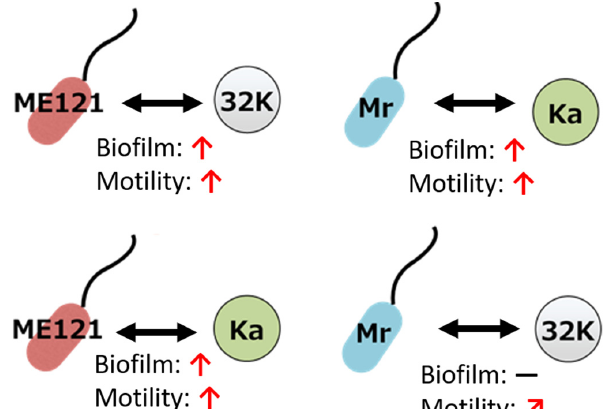
Figure 7. Schematic diagram of the effects on biofilm formation and motility of each strain. “ ↑ ” shows increased biofilm formation and accelerated motility. “ － ” shows no effect on biofilm formation. “ ↗ ” shows moderately accelerated motility.